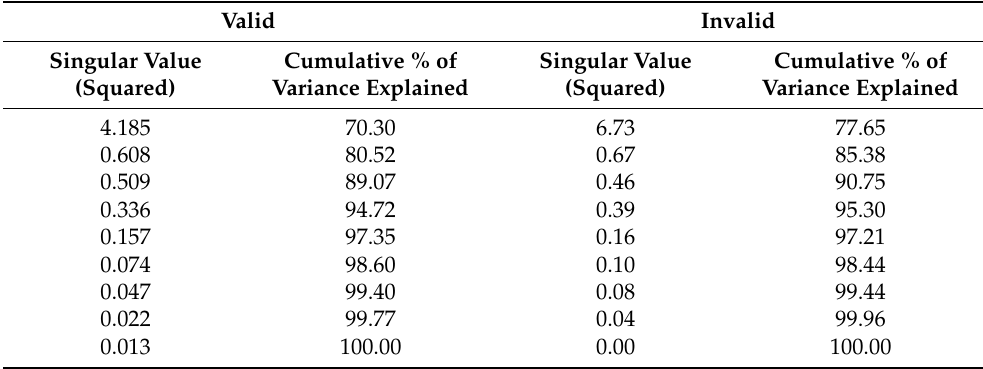
Table 9. Squared singular values extracted from SVD on matrix R , and their cumulative percent of explaining the total variance of R , for valid and invalid syllogism.